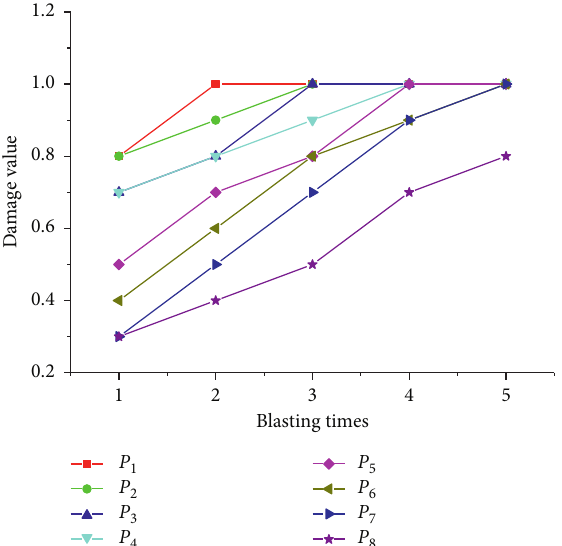
Figure 10: The curve of the relationship between cumulative damage of rock anchor beam monitoring points perpendicular to the axis of powerhouse and blasting